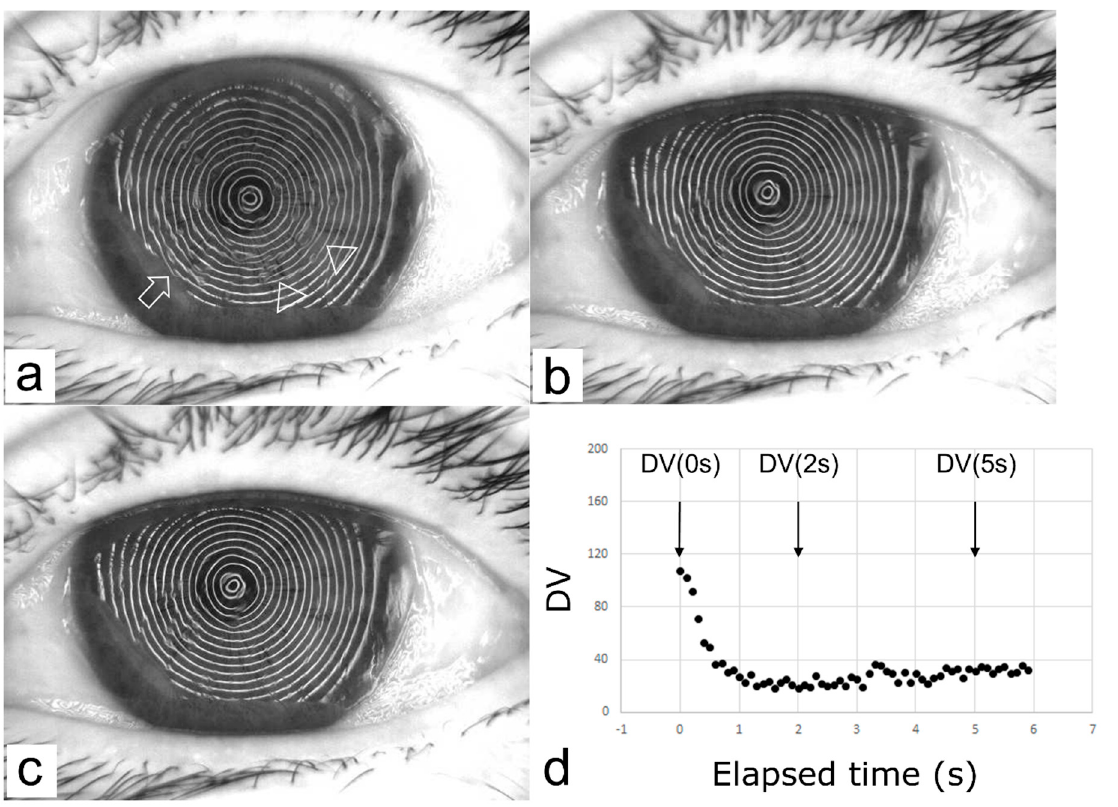
Figure 4. A representative case in the Spot Break (SB) group (the left eye of a 77-year-old female). MR distortions located at the temporal and lower part of the cornea appeared immediately after eye opening (( a ), arrowheads) were found to have already disappeared at 2 s ( b ) after the eye was kept open, a condition that remained even at 5 s ( c ) after eye opening. In contrast, MR distortion at the nasal lower part of the cornea appeared immediately after eye opening (( a ), arrow) remained unchanged during 5 s eye opening. A graph ( d ) represents this dramatic disappearance and consistent appearance of MR distortions by the disturbance value (DV) change over time. The stable baseline value of DV is thought to reflect that from the MR distortion at the nasal lower part.